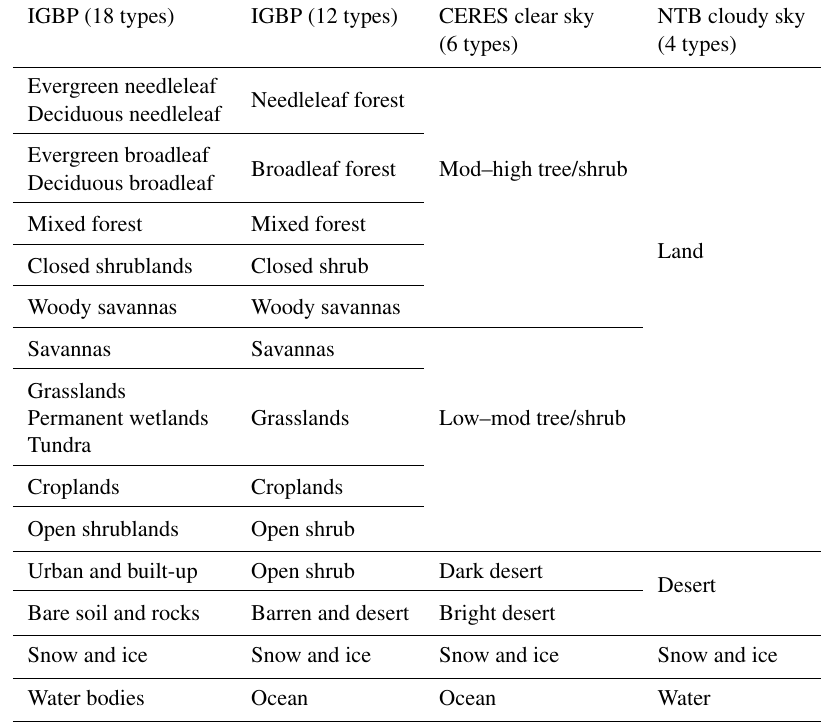
Table 2. Surface classification description for IGBP 18 types, IGBP 12 types, CERES clear sky 6 types, and NTB cloudy sky 4